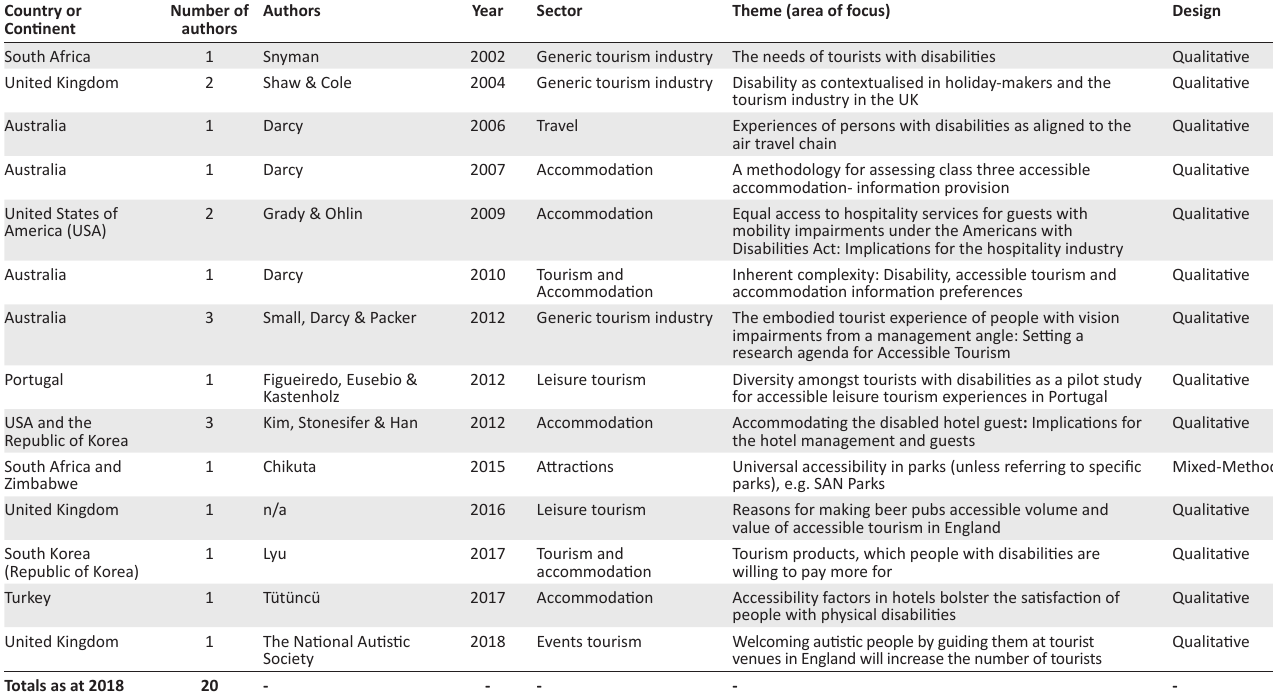
TABLE 6: Research on tourism products and services that accommodates disabled people (in sequential order of years). Country or Continent